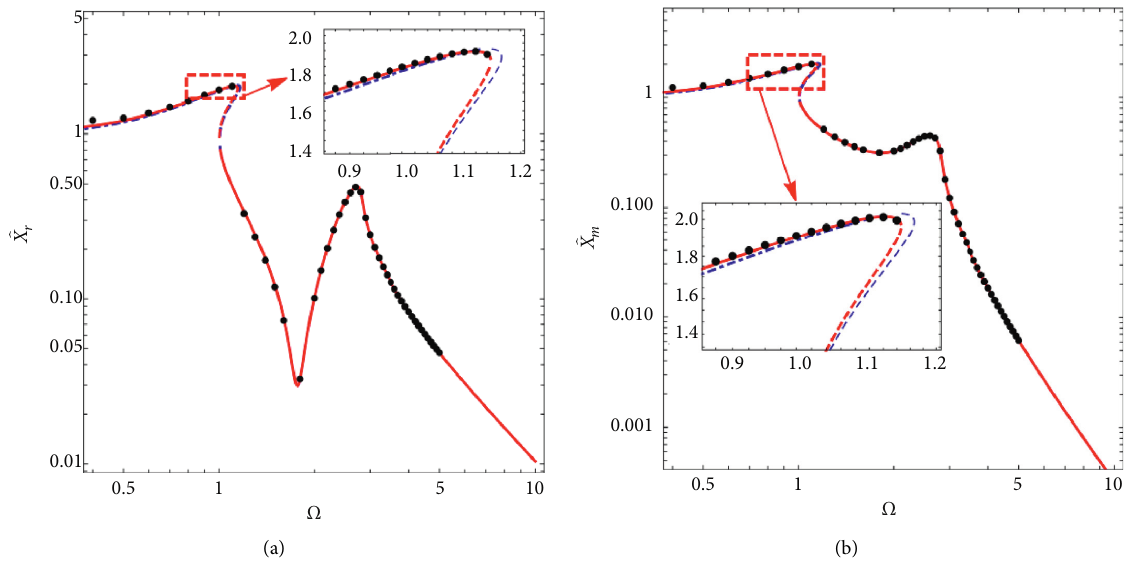
Figure 3: (a) Amplitude-frequency curves of the relative displacement between m